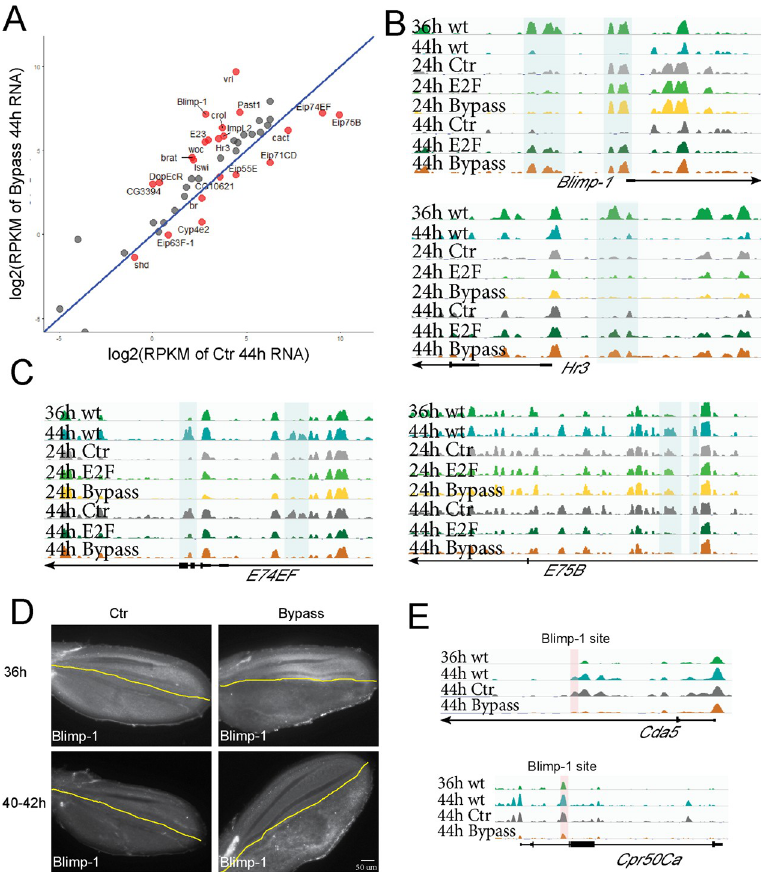
Fig 6. Bypassing cell cycle exit disrupts chromatin dynamics at ecdysone target genes and alters their expression. (A) Scatterplot of ecdysone-responsive genes in 44-h wings under conditions that bypass cell cycle exit versus normal exit. Genes with significant changes in expression are labeled in red. (B, C) Chromatin regions of Blimp-1 , Hr3 , E74 , and E75 fail to close or open at 44 h when cell cycle exit is compromised. (D) Blimp-1 antibody staining of wings at 36 h and 40–42-h wings with normal cell cycle exit (Ctr) or bypassed cell cycle exit in the posterior (using engrailed -Gal4/ Gal80 TS ). Compromising cell cycle exit delays the activation of Blimp-1 in a compartment-autonomous manner. (E) Peaks that fail to open at 44 h from cuticle-development genes harbor high-scoring Blimp-1 binding sites. The underlying data in Fig 6A can be found within S6 Data. Cda5, Chitin deacetylase-like 5; Cpr, Cuticular protein; Ctr, control; E2F, E2F transcription factor; Hr3, Hormone receptor 3; Gal80 TS , temperature-sensitive Gal80; RPKM, reads per kilobase of transcript, per million mapped reads; TEM, transmission electron microscopy; wt, wild type.